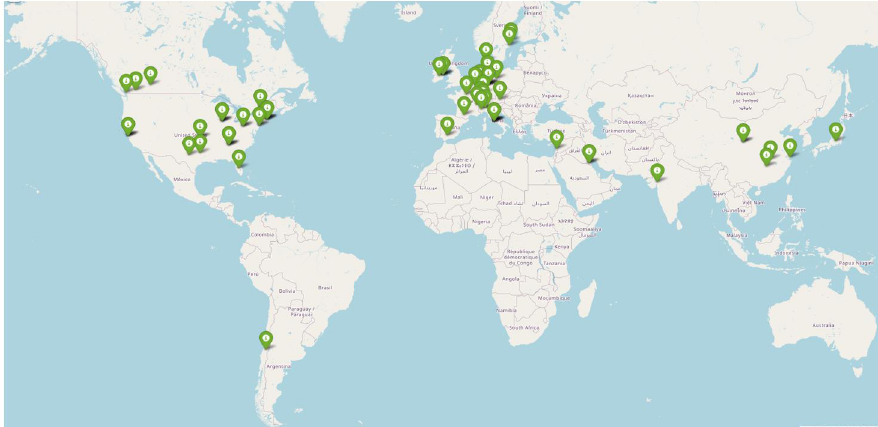
Figure 19. Location of physics-based urban building energy modeling case